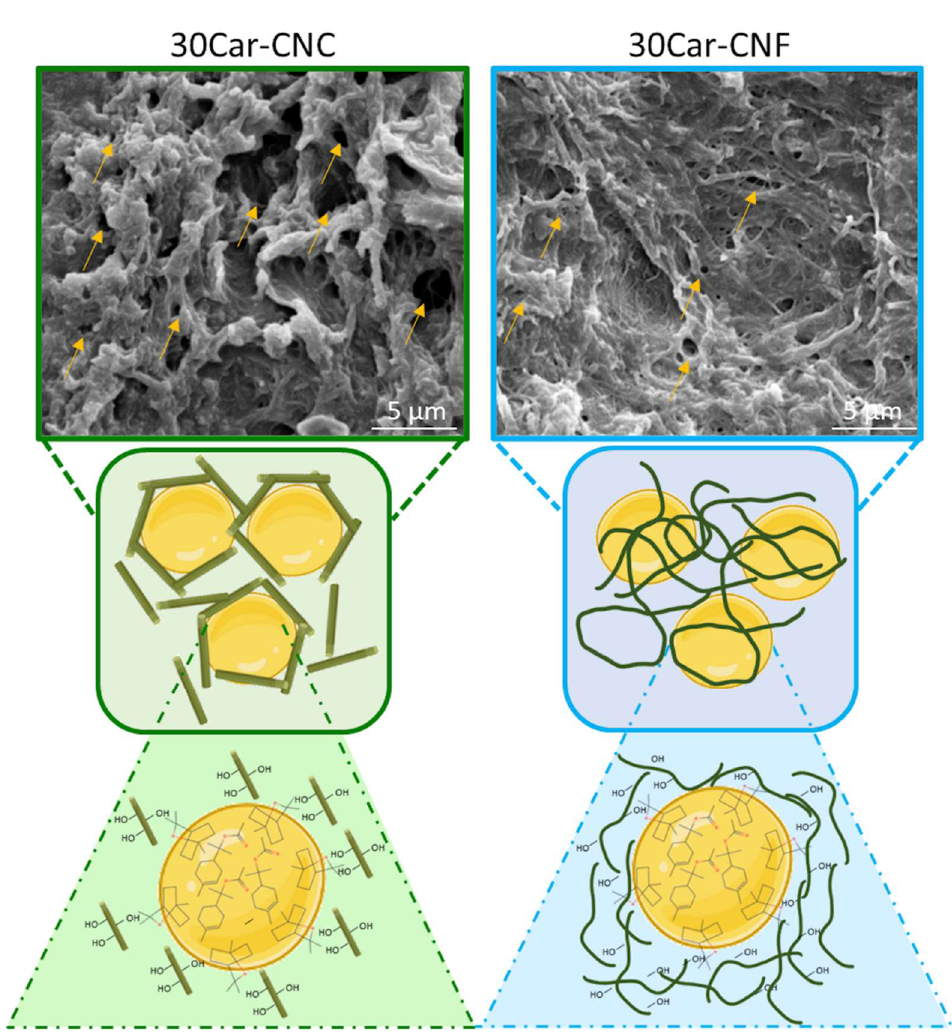
Figure 9. SEM images of 30Car–CNC and 30Car–CNF, a representative scheme of the stabilization mechanism, and the distribution of oil chemical structures (α-terpinyl acetate inside the droplet and 1,8-cineole at the interface) interacting with cellulose.